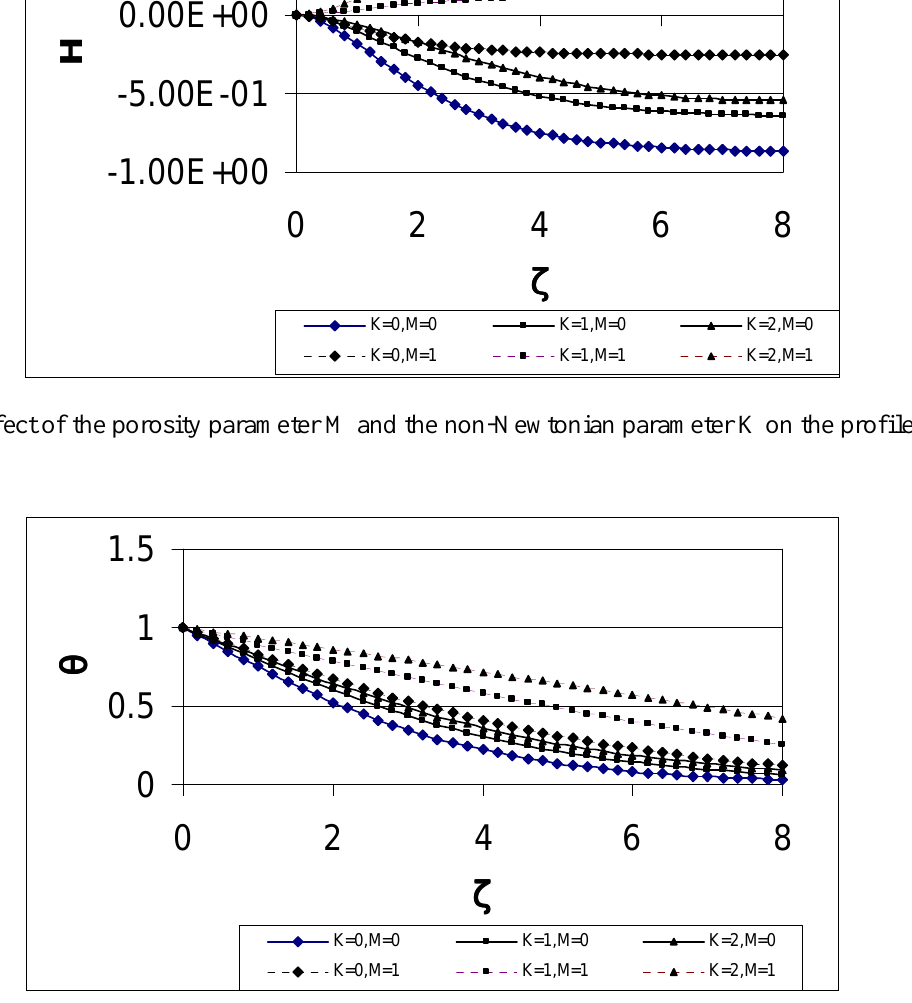
Fig. 6. Effect of the porosity parameter M and the non-Newtonian parameter K on the profile of q